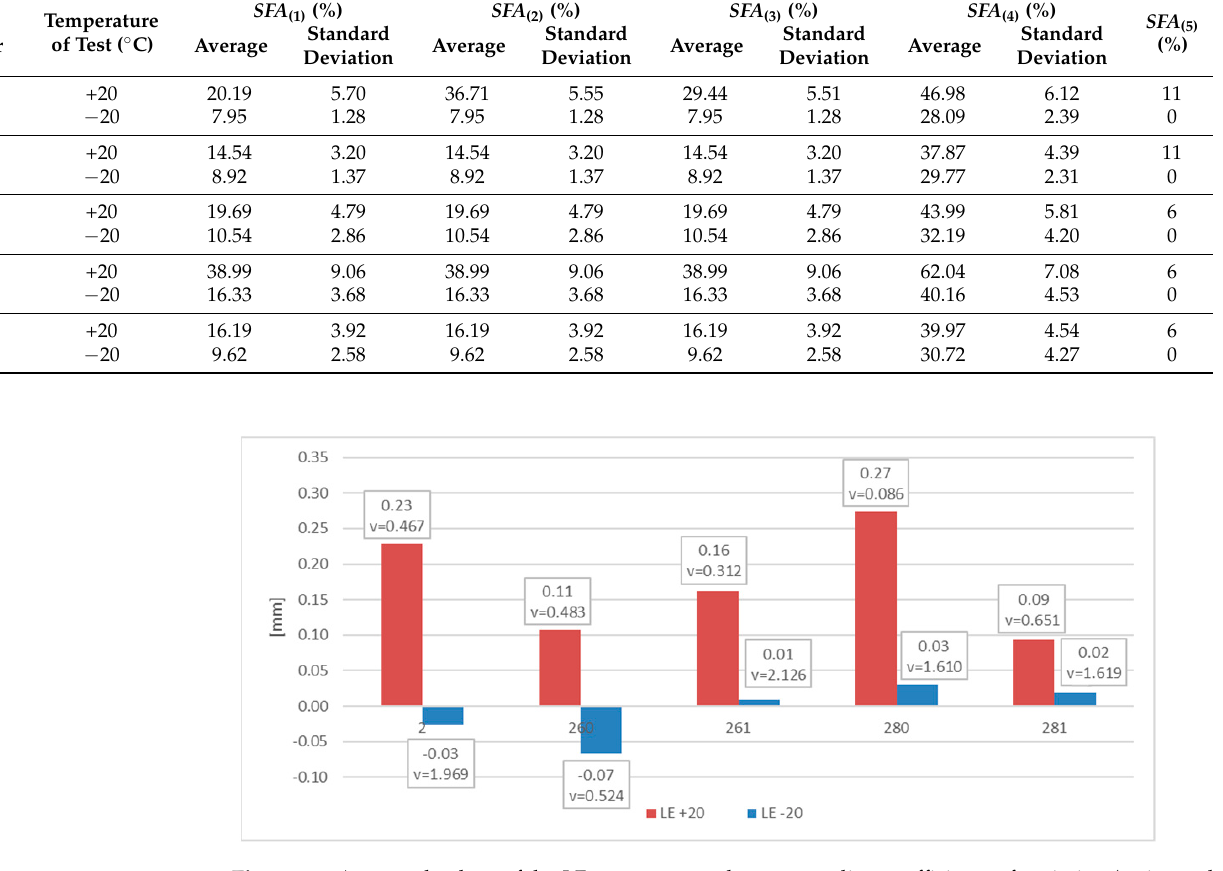
Figure 17. Relationship between averaged values of LE parameter and related values of fracturing energy W t obtained for X20Cr13 steel at di ff erent testing conditions. Negative values of the LE parameter obtained for this steel during the tests conducted at − 20 °C, accompanied by very low impact strength determined, should be understood